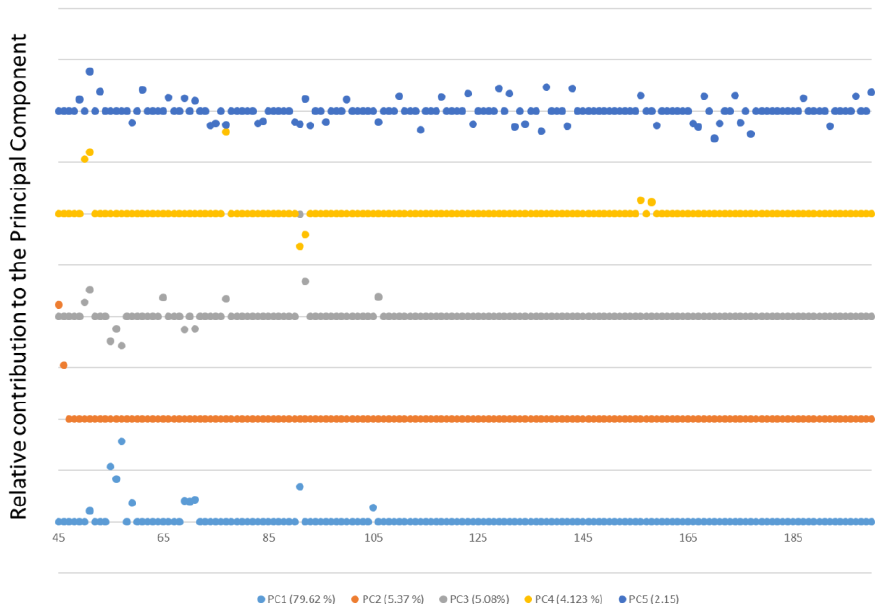
Figure 3. Loadings for the first five factors resulting from principal components analysis (PCA) using the signals from the E-Nose system.